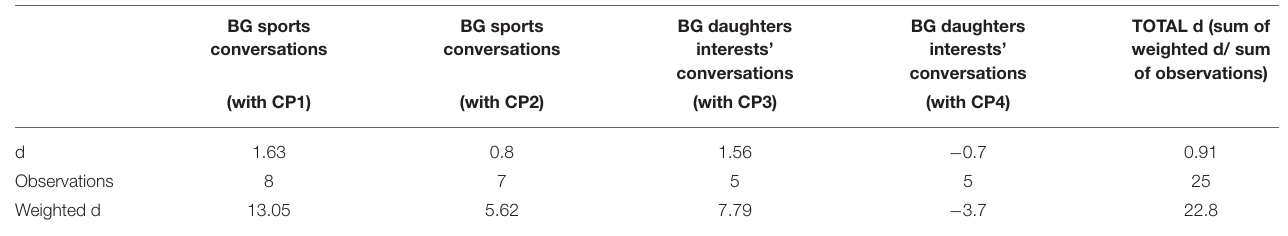
TABLE 2 | Treatment effect size with each conversation partner